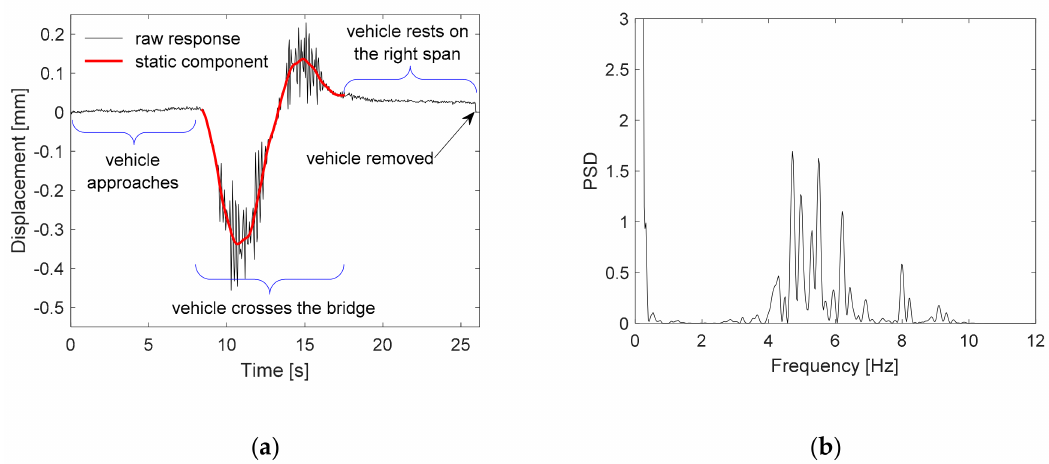
Figure 5. Node 1’s displacement time history ( a ) and its PSD plot ( b